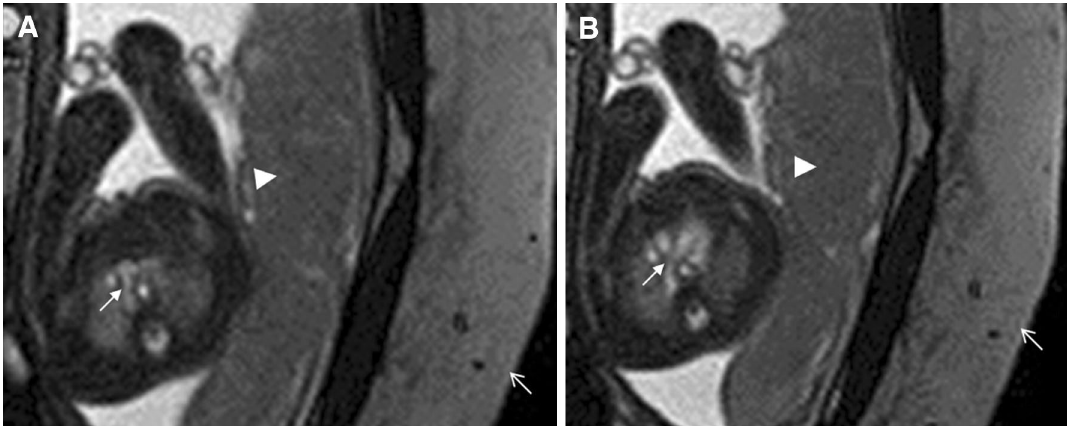
Figure 4. A 25-week-old foetus with a right aortic arch and right ductus arteriosus. Foetal CMR B-TFE transverse view of the aortic arch image showing the right-sided aortic arch ( A , arrow) and the right-sided ductus ( B , arrow), maternal obesity ( A , B , open arrow), and placenta located in the anterior uterine wall ( A , B ,